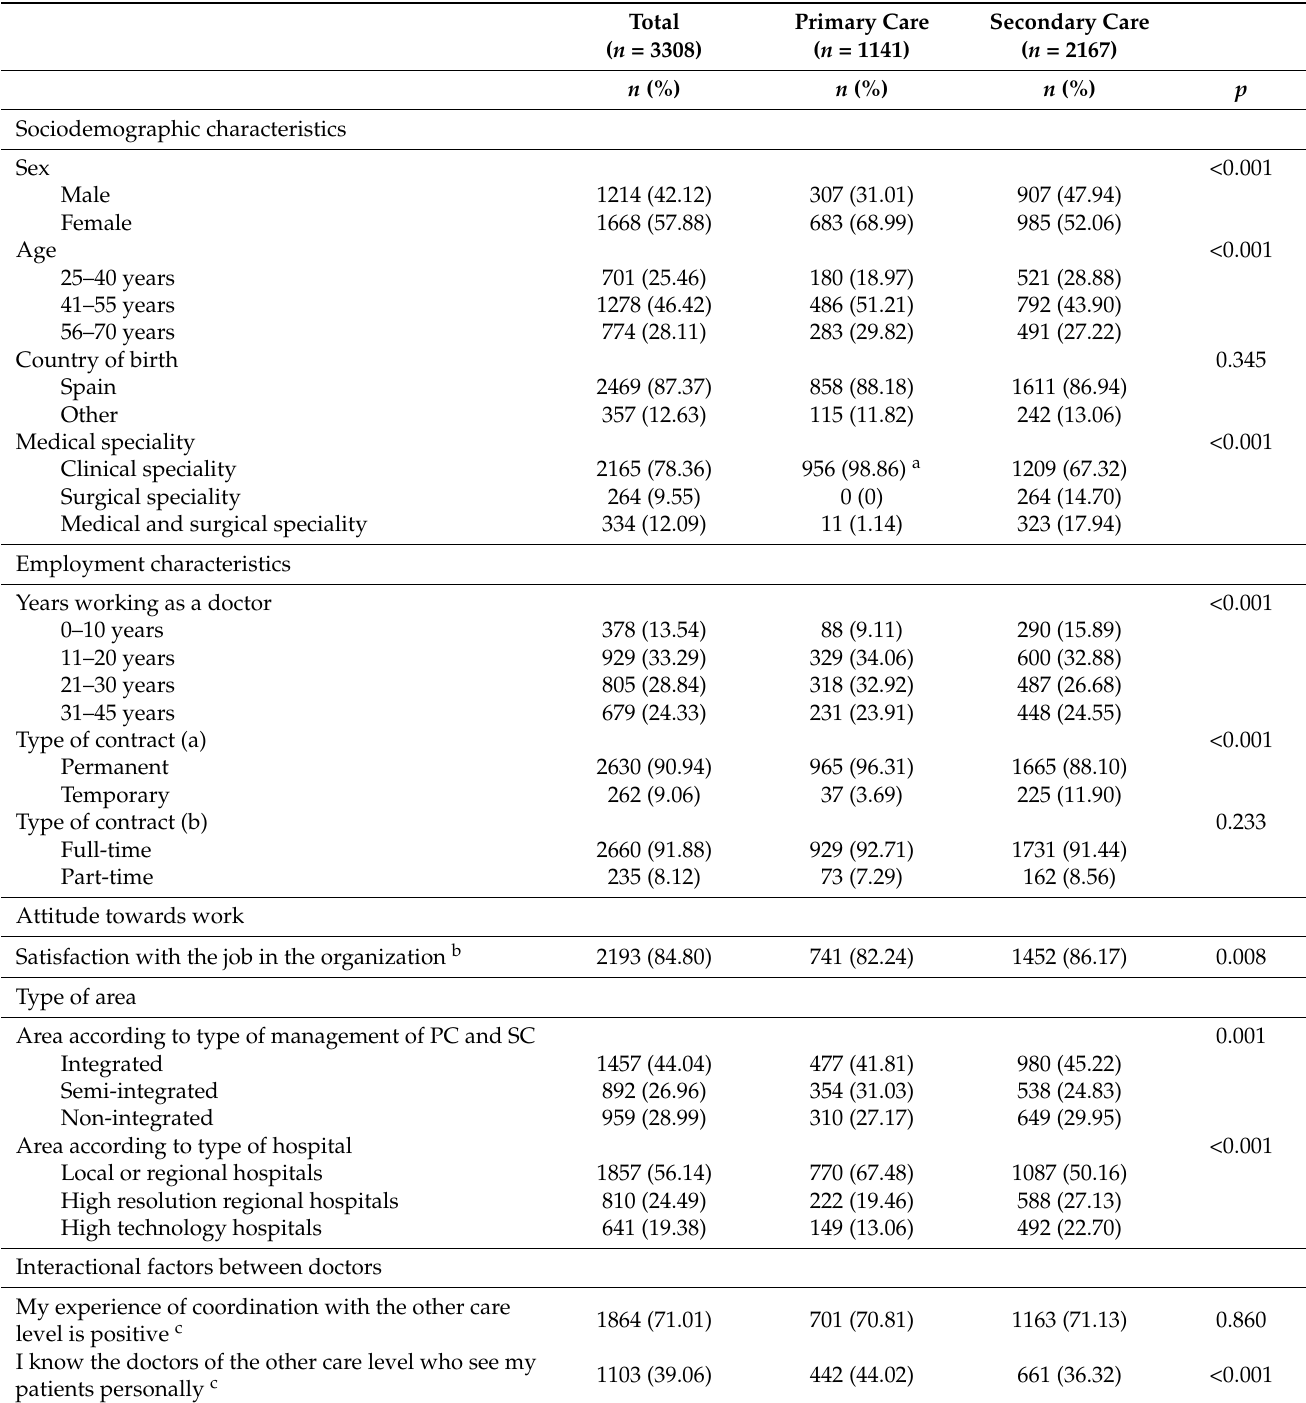
Table 1. Description of the sample characteristics, by level of